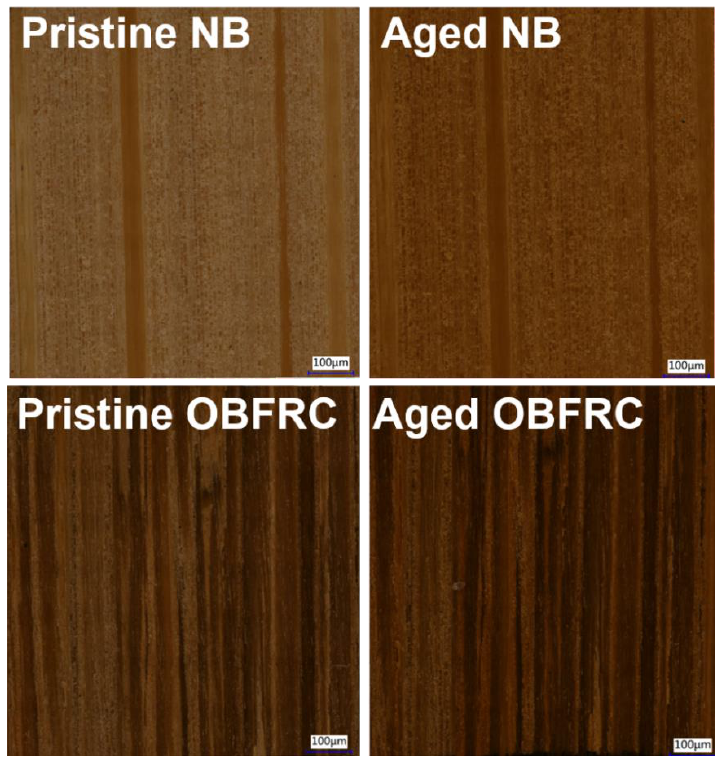
Figure 2. Visual appearance of a 5000 µ m × 5000 µ m region of natural bamboo (NB) and OBFRC surface before and after UV irradiation for 200